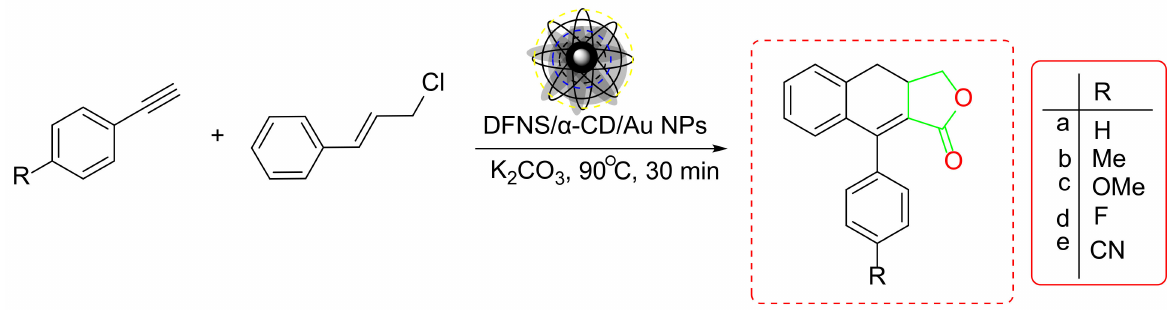
Scheme 3. A synthetic protocol for DFNS/ α -CD/Au-NC-catalyzed synthesis of 3a,4-dihydronaphtho[2,3-